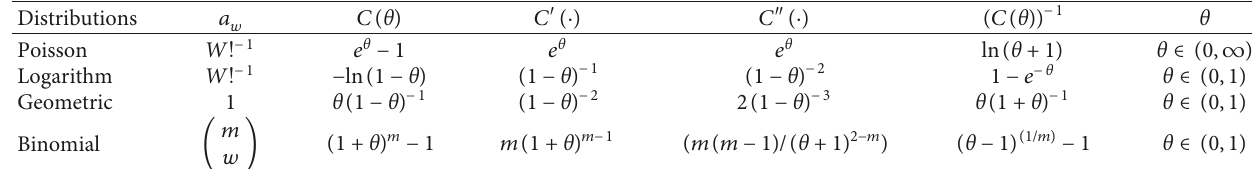
Table 1: Important quantities of the PS